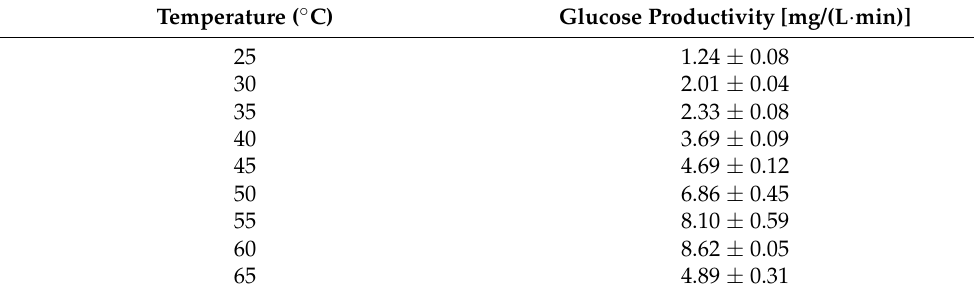
Table 1. Glucose